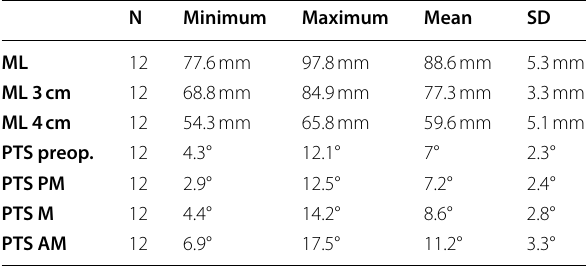
ML, mediolateral; ML 3 cm, mediolateral 3 cm from the joint line; ML 4 cm, mediolateral 4 cm from the joint line; SD, standard deviation; PTS, posterior tibial slope; PM, posteromedial; M, medial; AM, anteromedial